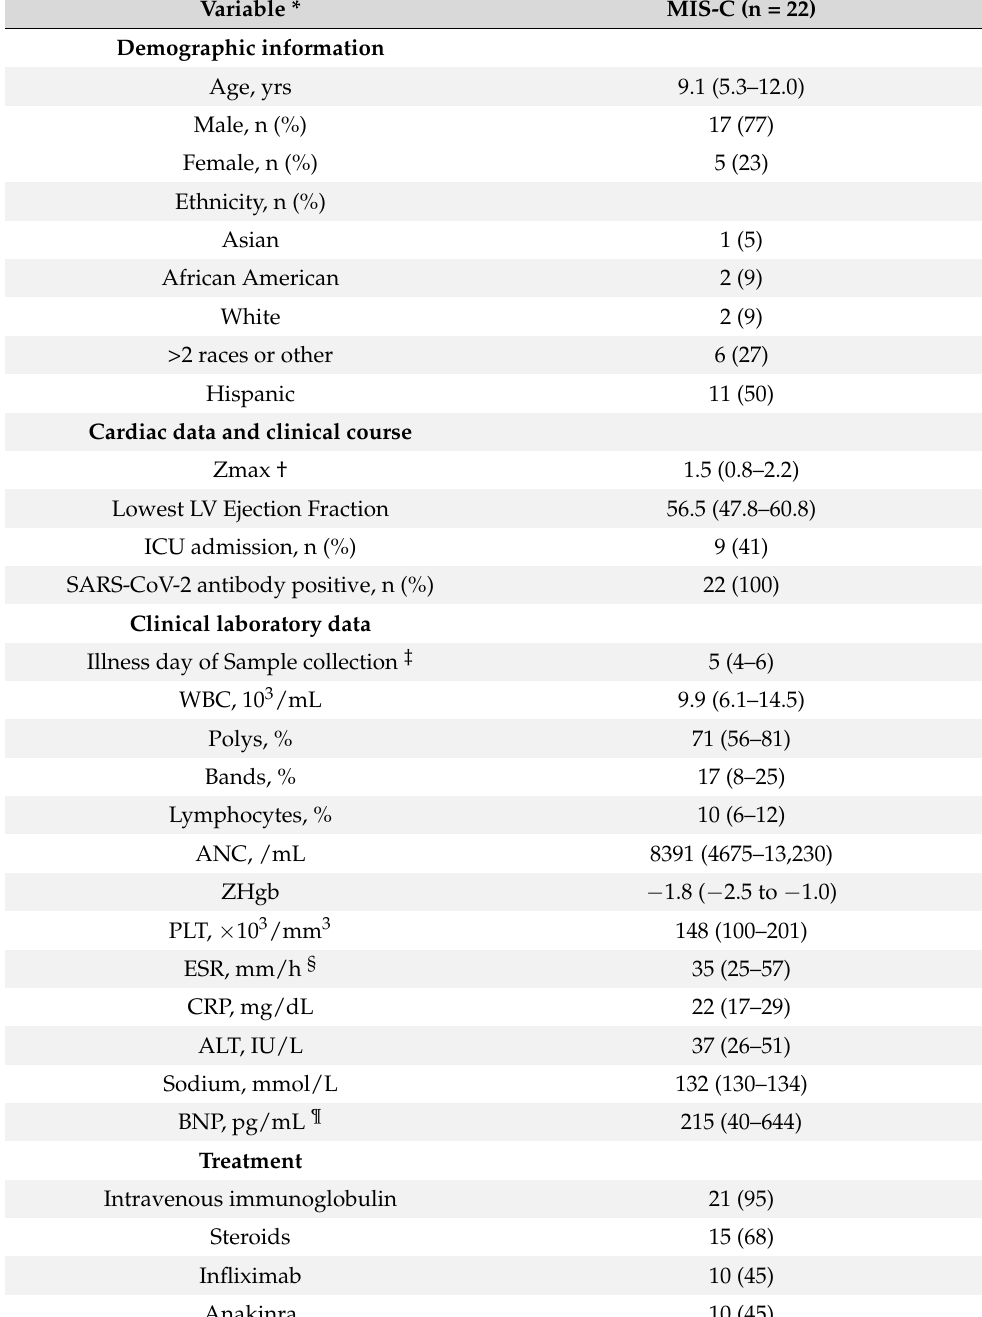
Table 1. Demographic and clinical characteristics of MIS-C